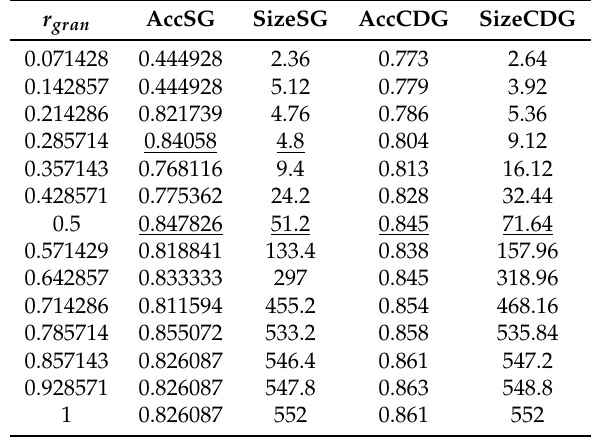
Table 11. Exemplary result for Standard vs. Concept-Dependent Granulation—5 times Cross Validation 5; Australian Credit data set; r gran = Granulation radius, AccSG = Accuracy of classification for Standard Granulation, AccCDG—Accuracy for Concept-Dependent Granulation, SizeSG = Granular decision system size for Standard Granulation, SizeCDG = Granular decision system size for Concept-Dependent Granulation.